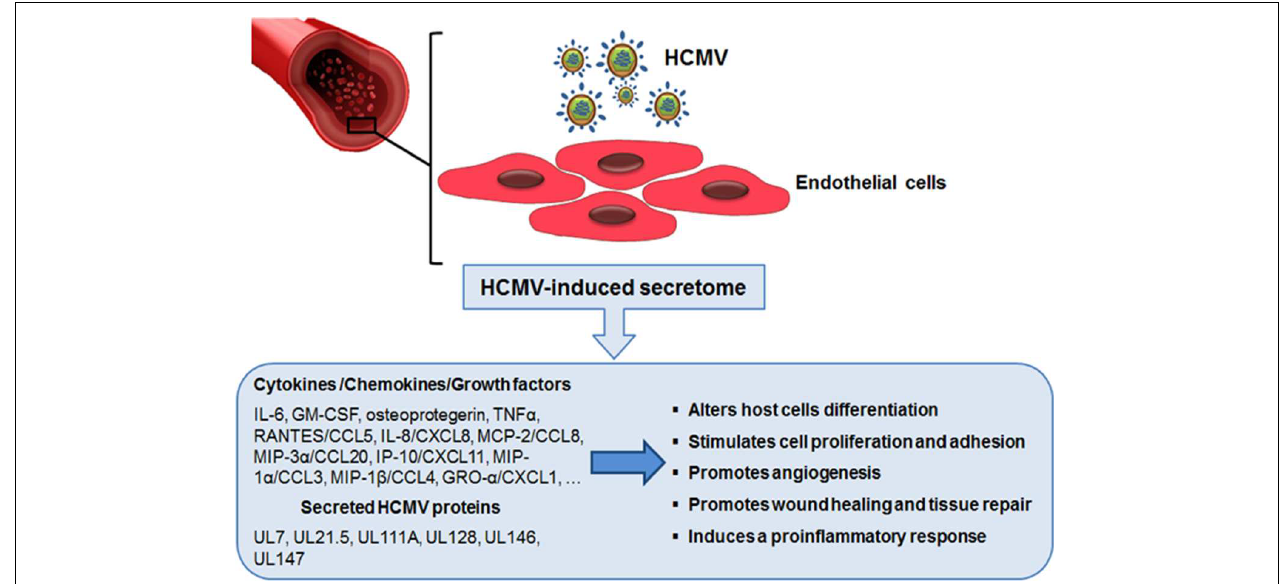
FIGURE 2 | The role of endothelial cell-derived HCMV secretome in accelerating vascular diseases. Productive HCMV infection of endothelial cells leads to the release of many bioactive proteins that can modify the microenvironment around host cells. The ability of these secreted factors to promote neo-vessel formation, wound healing, and the inflammatory response may help explain the role of HCMV infection in the development of HCMV-associated vascular